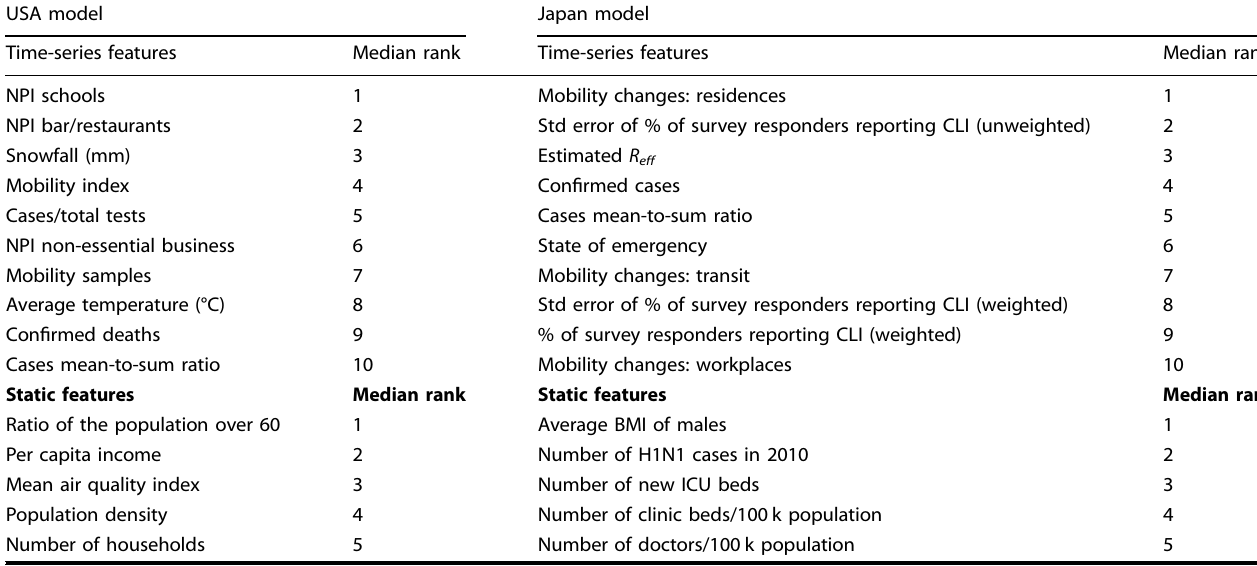
Table 1. Model feature